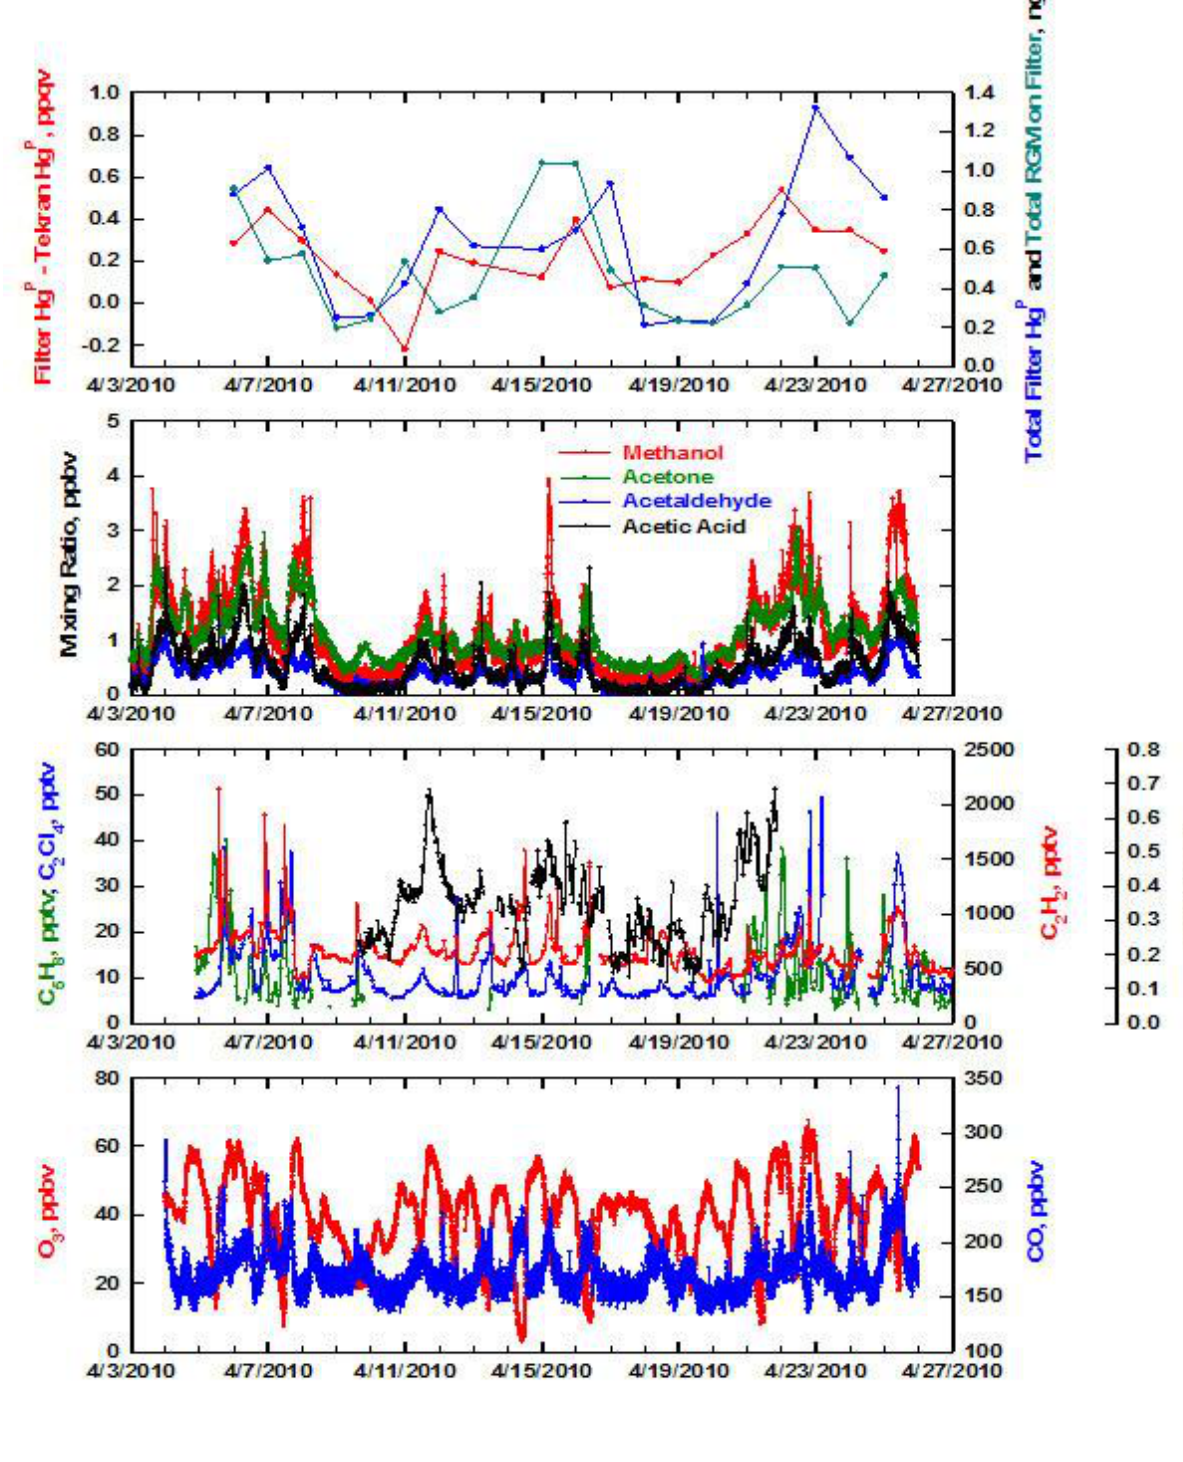
Figure 6. Top panel—Comparison of total Hg from potential collection of all RGM on filter during the winter sampling interval at Thompson Farm. Middle panels—Time series of selected hydrocarbon/halocarbons/oxygenates/HCN. Bottom panel—Time series of O and